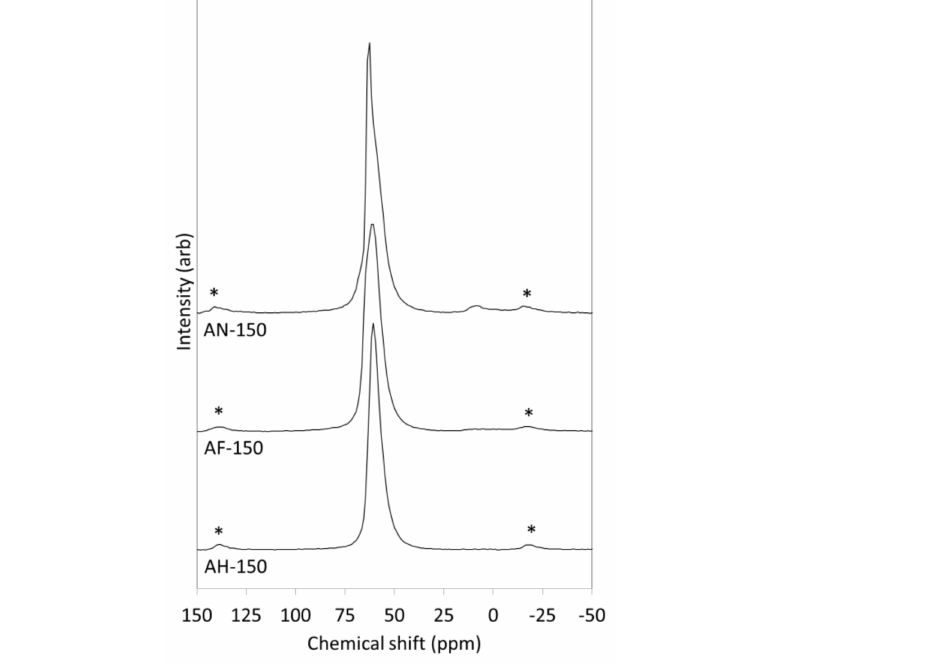
Figure 4. 27 Al MAS NMR spectra of hydrothermal products of amber container glass and aluminium nitrate (AN-150), aluminium foil (AF-150) and amorphous aluminium hydroxide waste (AH-150)